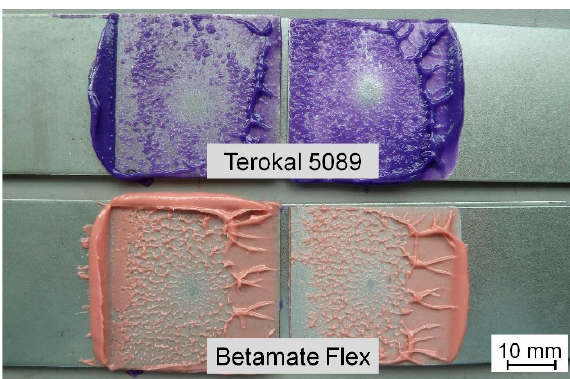
Figure 8. Distribution of adhesive Betamate Flex and Terokal 5089 after being squeezed.